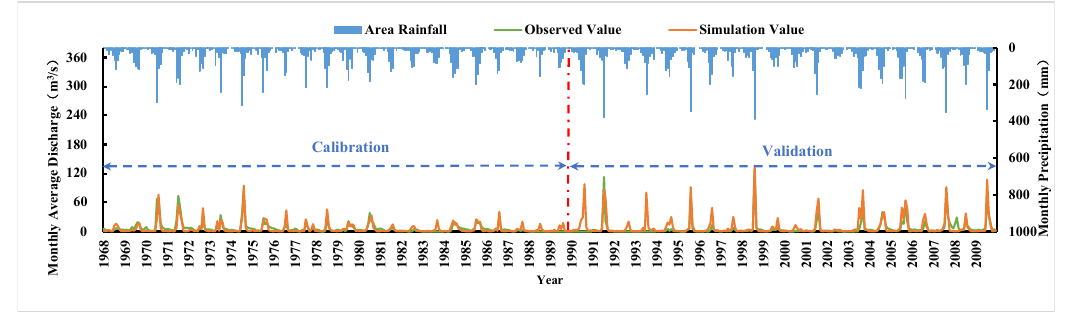
Figure 5. Calibration and validation of model. Table 1. Simulation effect of surface monthly runoff at Shuyuan hydrological station.